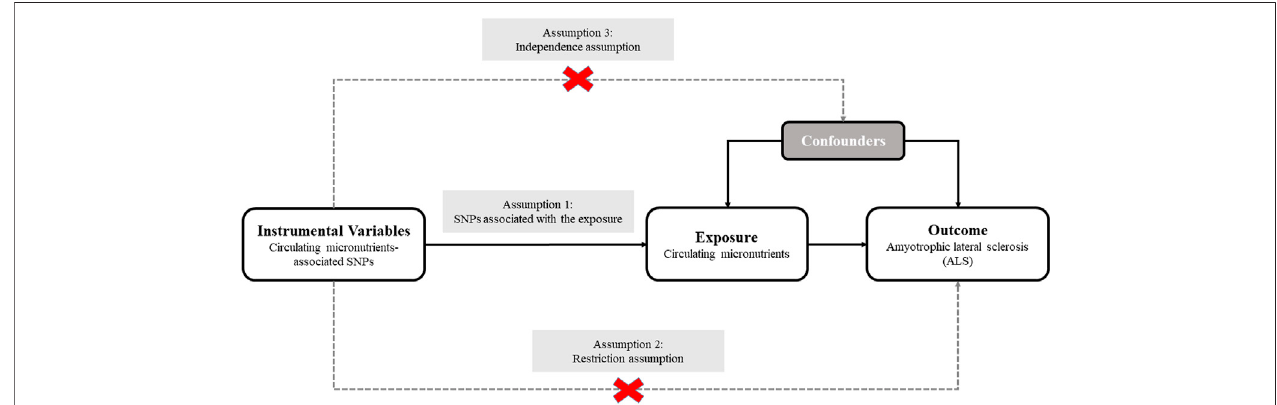
FIGURE 1 | The overall design of Mendelian randomization analysis in the present